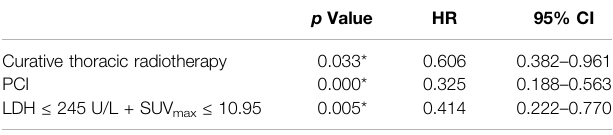
TABLE 2 | Univariate analysis of prognosis in 118 patients with SCLC.